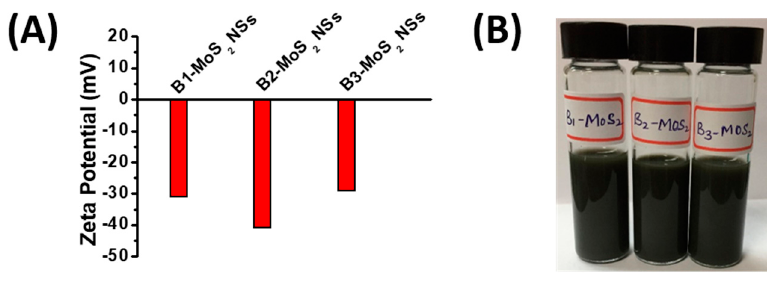
Figure 4. ( A ) Zeta potential analysis and ( B ) optical images water soluble MoS 2 NSs.